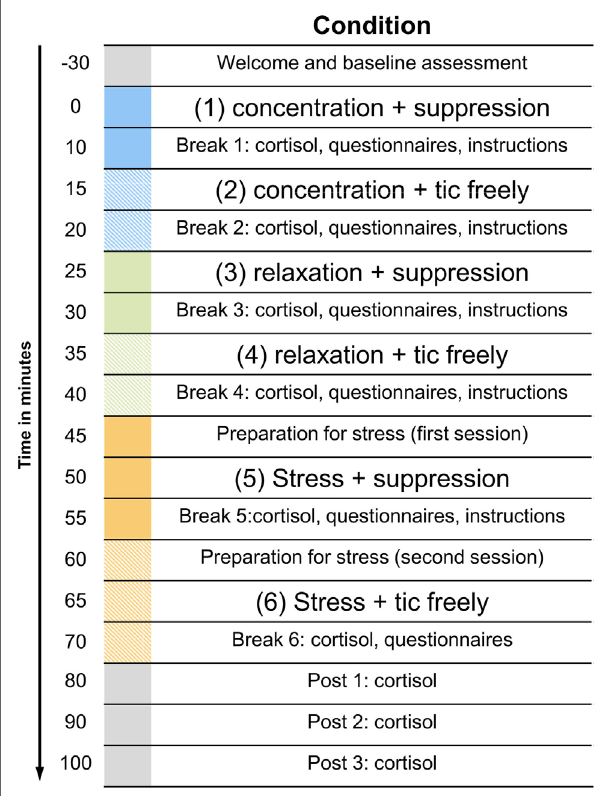
FigUre 1 | illustration of the experimental procedure . The figure displays only one of the possible sequences. The order of the three situations with the different levels of arousal as well as the order of the instructions within these situations was